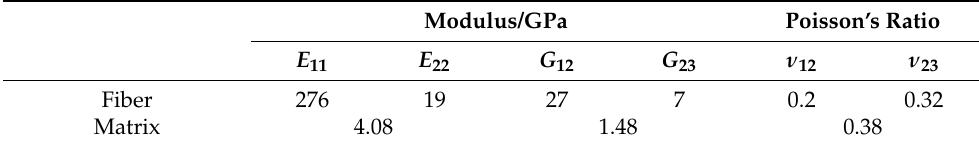
Figure 4. Material coordinate systems of the RVE of braided composite. Table 2. Constituent properties for the braided